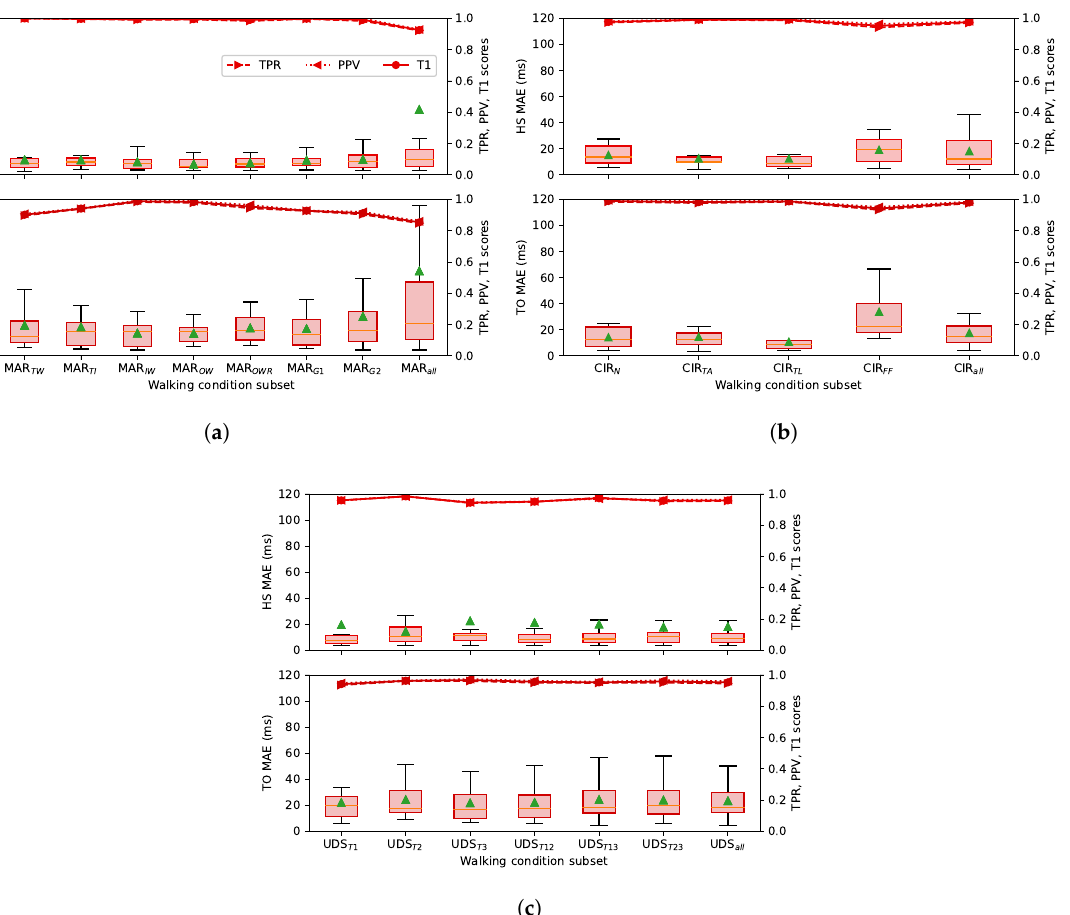
Figure 9. MAE, FPR, PPV and T1 score of the ESN as a function of the subsets of walking condition. ( a ) MAREA database; ( b ) CIRRIS database; ( c ) UDS database. The mean value of MEA is expressed as a green triangle and the median as a central line, while boxes are the 25th and 75th percentiles and the whiskers are the extensions of the last value of MAE ik of the distribution over and under 1.5 times the interquartile range. The values of TPR, PPV and T 1 are plotted with three lines and are relative to the right-side axis. (Same for all